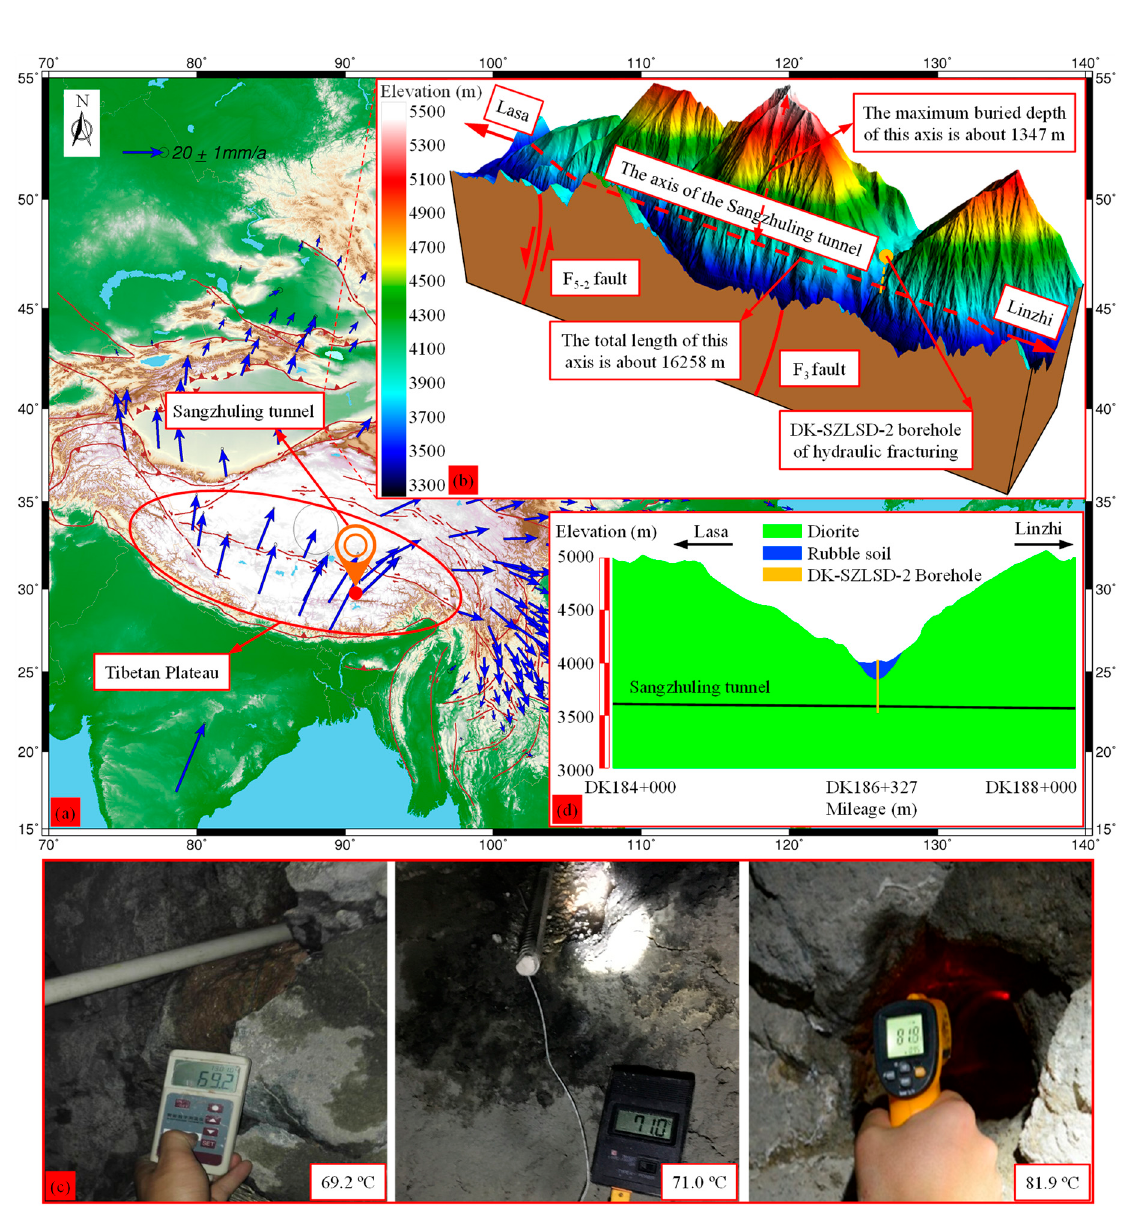
Figure 6. The general situation of the Sangzhuling tunnel: ( a ) the GPS velocity field of Crustal Movement Observation Network of China with respect to Eurasia [43]; ( b ) the topography of the Sangzhuling tunnel; ( c ) the measured virgin rock temperatures in the Sangzhuling tunnel; ( d ) the longitudinal section of the Sangzhuling